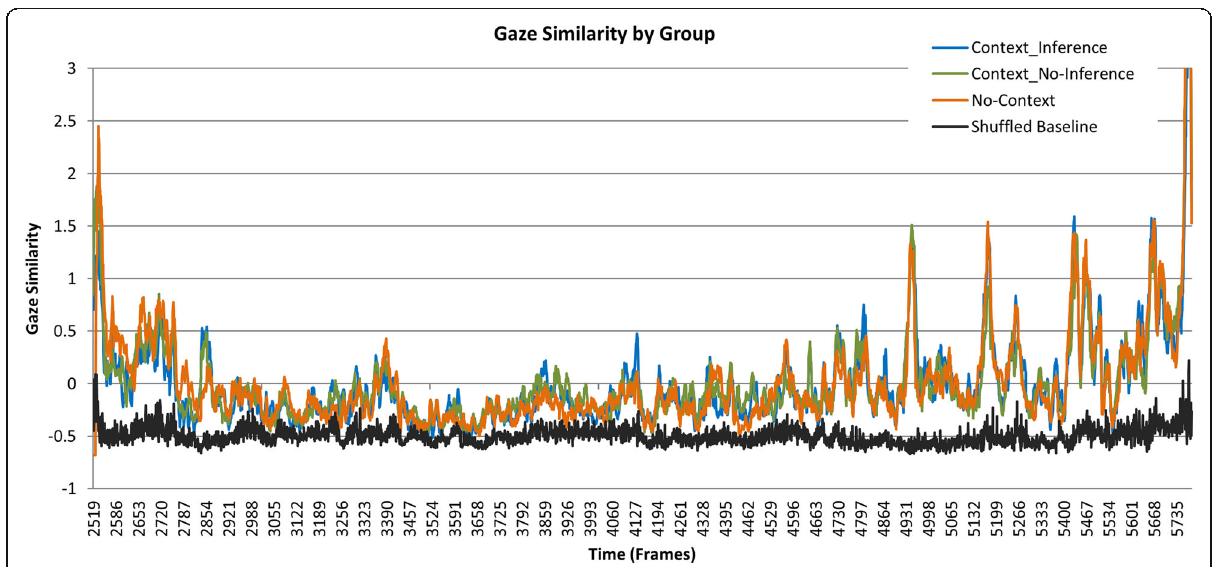
Fig. 4 Similarity of gaze by context condition across the shared viewing period of the clip that starts on frame 2519 (thus, the figure appears different from Fig. 2). Gaze similarity is expressed as a z-score probability relative to the context condition and inference made (Context+Inference [ blue ], Context + No-Inference [ green ], No-context [ orange ], and shuffled baseline [ black ]). Larger values indicate greater attentional synchrony. The shuffled baseline ( black ) indicates chance level gaze similarity for the